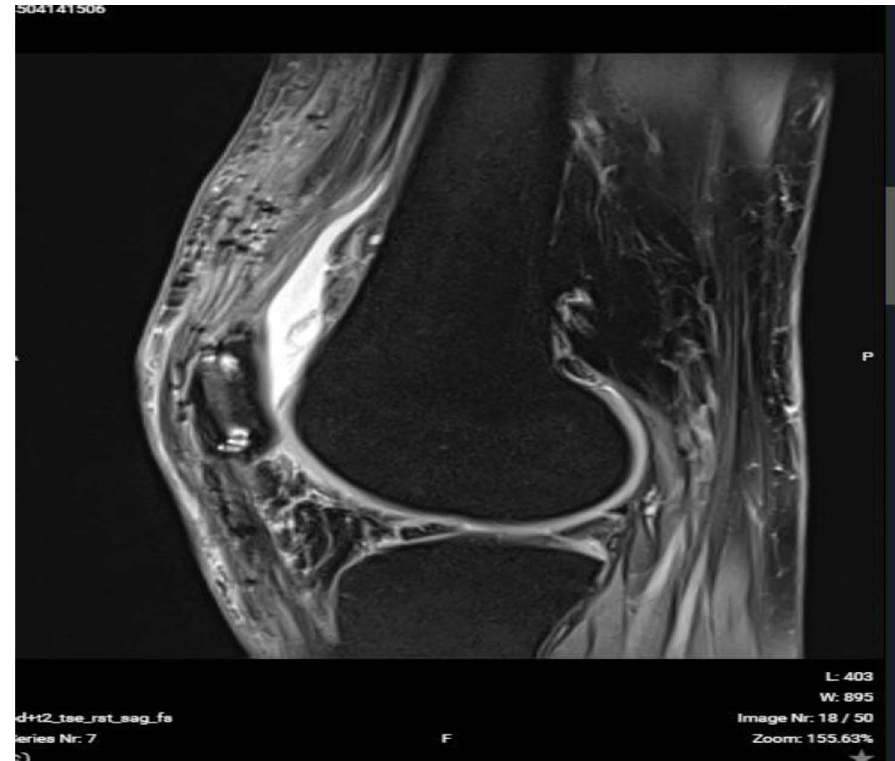
Figure 2. Post operative MRI: Notice the improvement of the patellar height and quadriceps fi brosis.